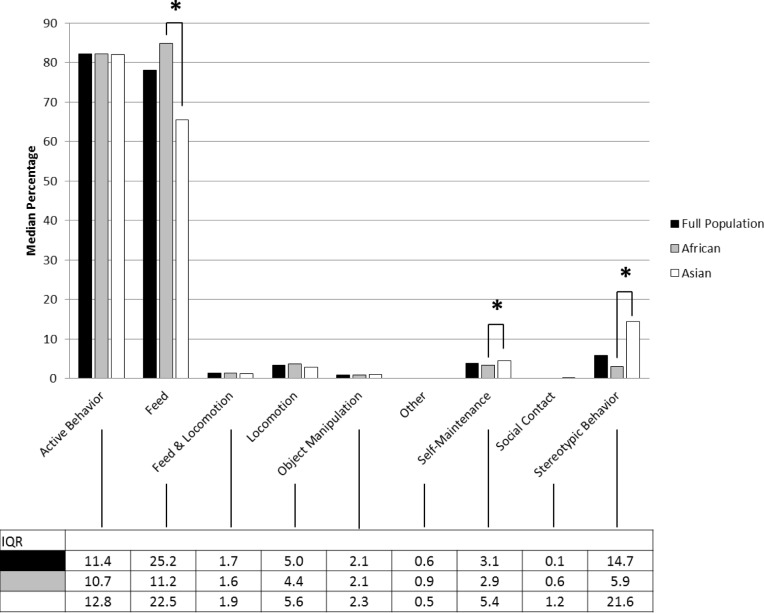
Median daytime active behavioral observation percentages and interquartile ranges.Asterisks represent significant species differences (p<0.05). For the full population, African and Asian elephants, the median values for Other were zero. The median values for Social Contact were also zero in full population and African elephants.